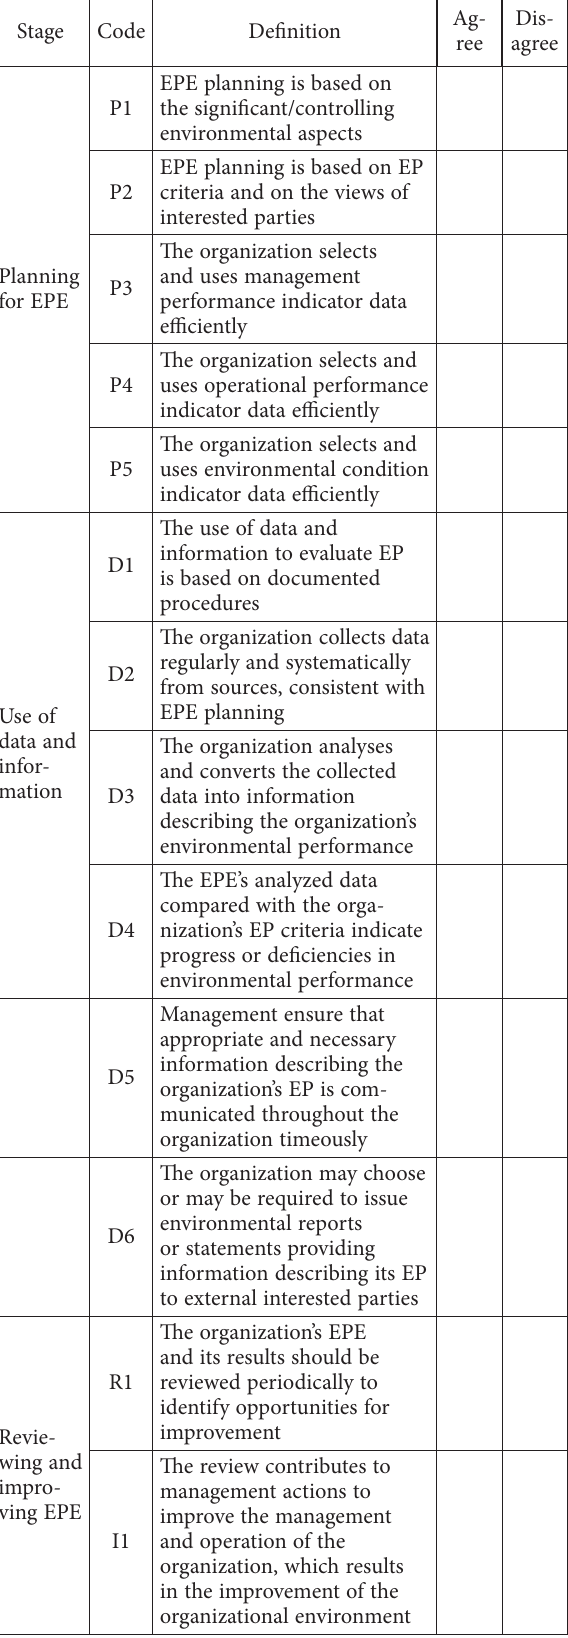
Table 1. Questionnaire items on the implementation of